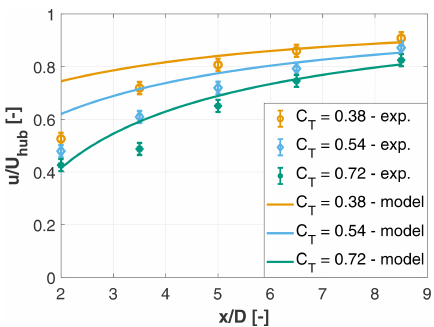
Figure 14. Velocity deficit evolution in UTD-HT inflow, for sev- eral values of C T , compared to the wake model of Bastankhah and Porté-Agel (2014).